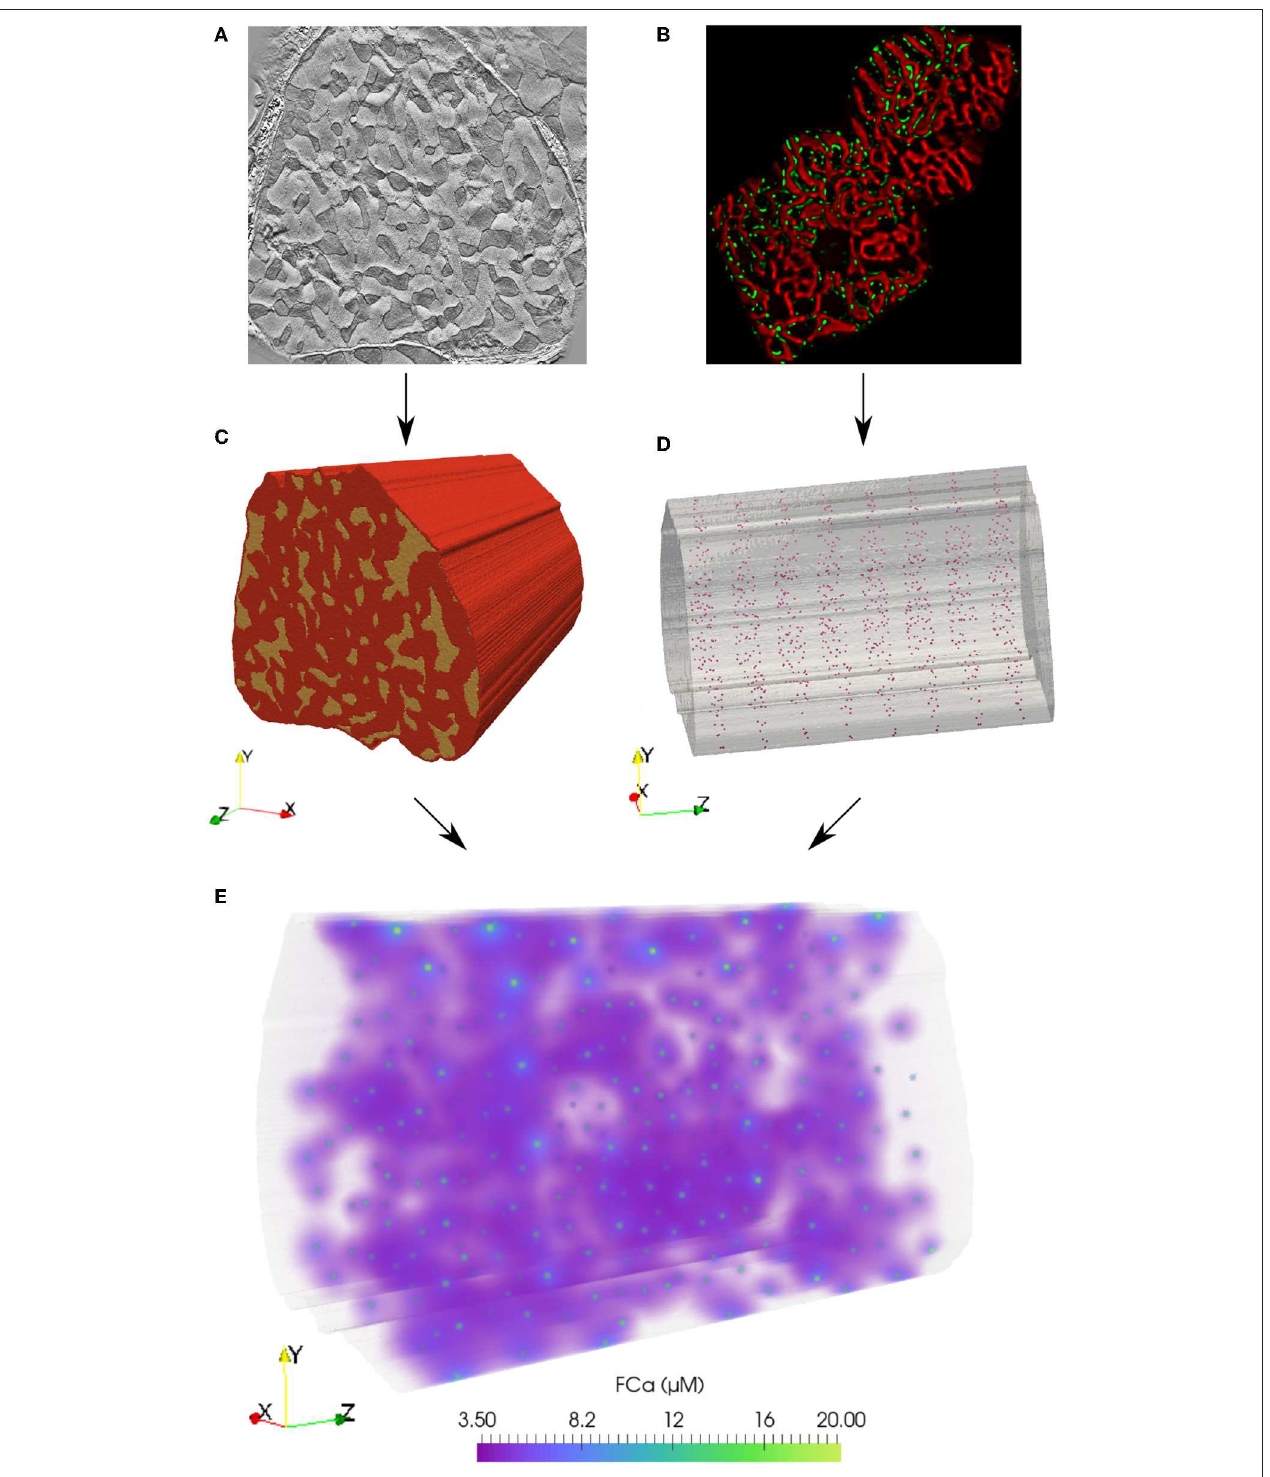
FIGURE 1 | Finite element model of Ca 2+ reaction-diffusion in an eight sarcomere section of a cardiomyocyte. (A) From an electron tomography imaging stack, myofibril and mitochondria regions were segmented from a slice at the depth of a z-disk. (C) This geometry was extruded 16 µ m (in the direction shown as z here) to create a three-dimensional eight-sarcomere model. Mitochondrial regions shown in yellow; red volume indicates the myofibrillar and cytosolic region. (B) Statistical analysis of immuno-labeled microscopy data (RyR clusters shown in green) was used to determine inter-cluster spacing distributions. (D) RyR cluster locations in the